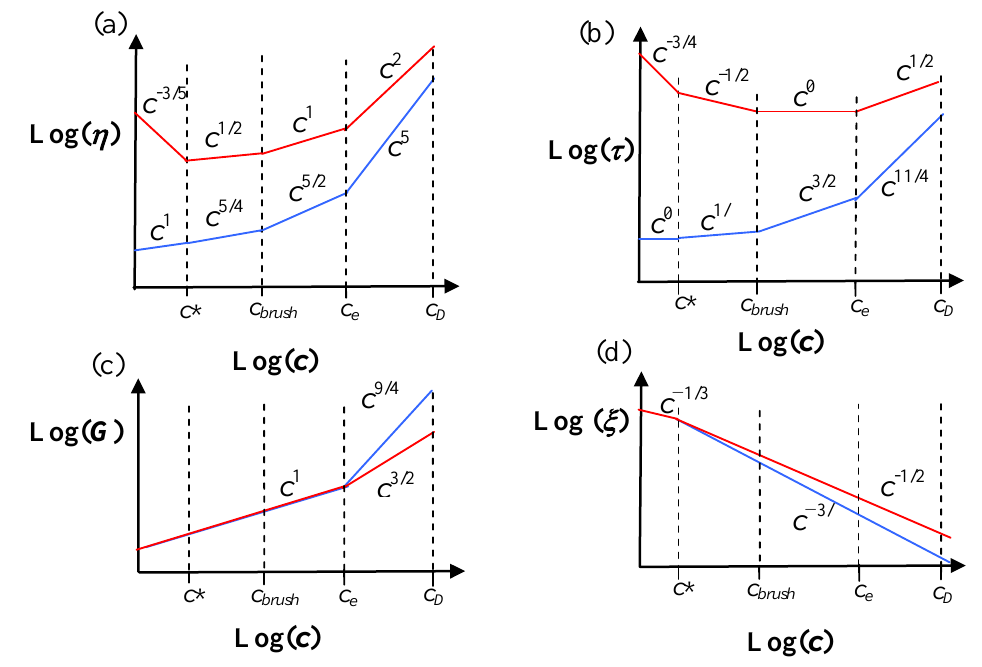
Figure 2. Collection of scaling results for both neutral and charged flexible combs with unentangled side-chains. The predictions for neutral combs are in blue, and charged combs are in red [6]. (a) Specific viscosity ( η ). (b) Relaxation time ( τ ). (c) Modulus (G). (d) Correlation length ( ξ ). The quantities are shown as a function of polymer concentration (c). c * is the semi-dilute overlap concentration, c is the brush overlap concentration, c brush e is the entanglement concentration and c is the electrostatic blob overlap concentration. D Note that c *, c and c are not expected to coincide for both neutral and charged brush e